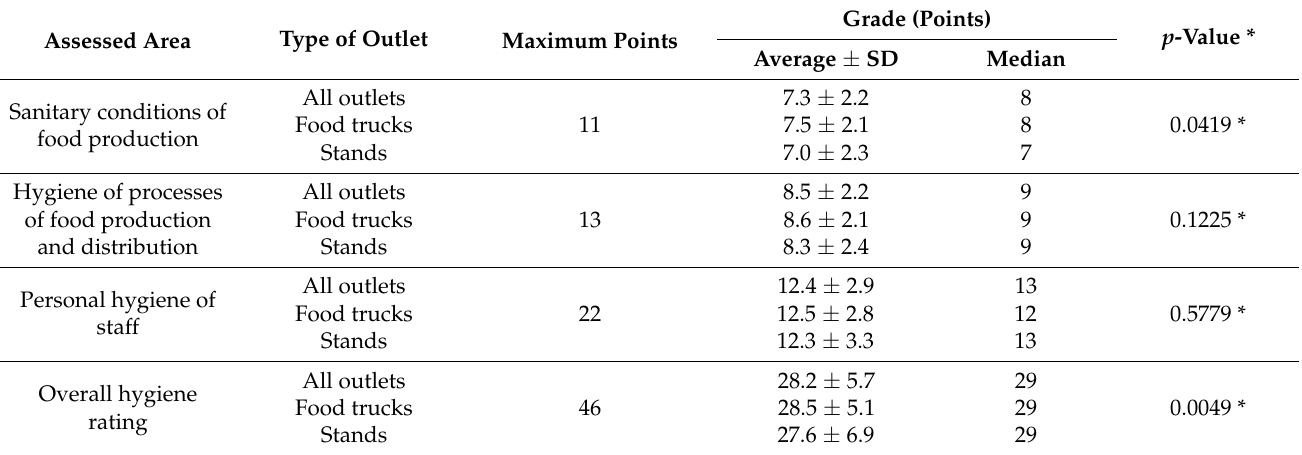
Table 3. Results of the overall evaluation of street food vendor